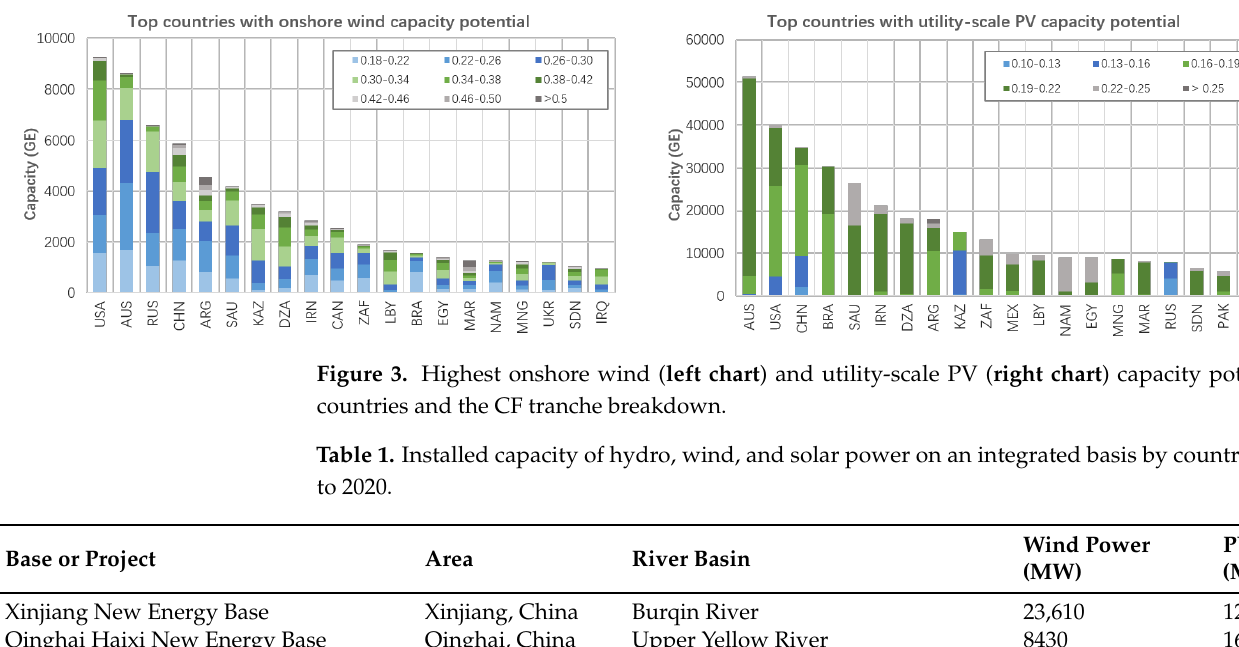
Figure 2. Changes in the total installed capacity of renewable energy by continent from 2012 to 2021.